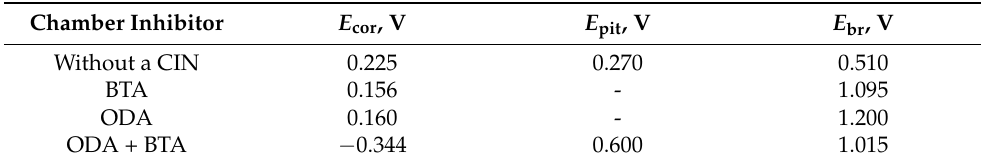
Table 4. Effect of copper CT on the characteristics of anodic potentiodynamic curves. T CT = 100 ◦ C, and τ CT = 60 min.